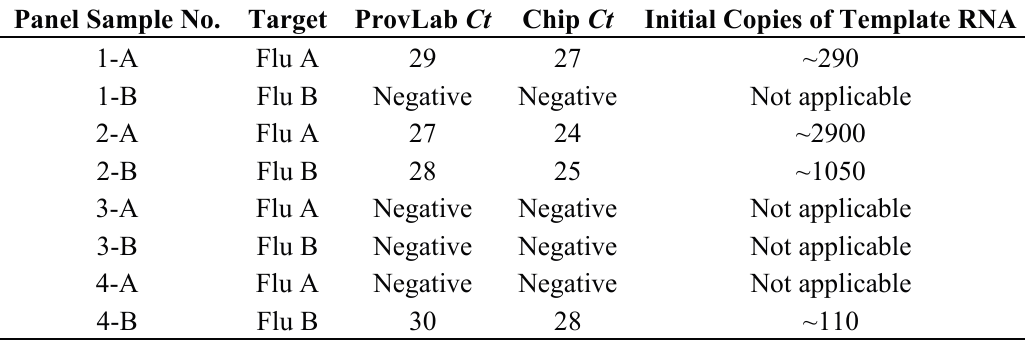
Figure 7. Photomicrographs showing the fluorescent images corresponding to the eight PCR droplets and the extracted plot of the eight qRT-PCR curves ( I p in μ A). Table 4. Outcomes of the micro-device qRT-PCR assay using mixed panel samples of Table 1c. Panel Sample